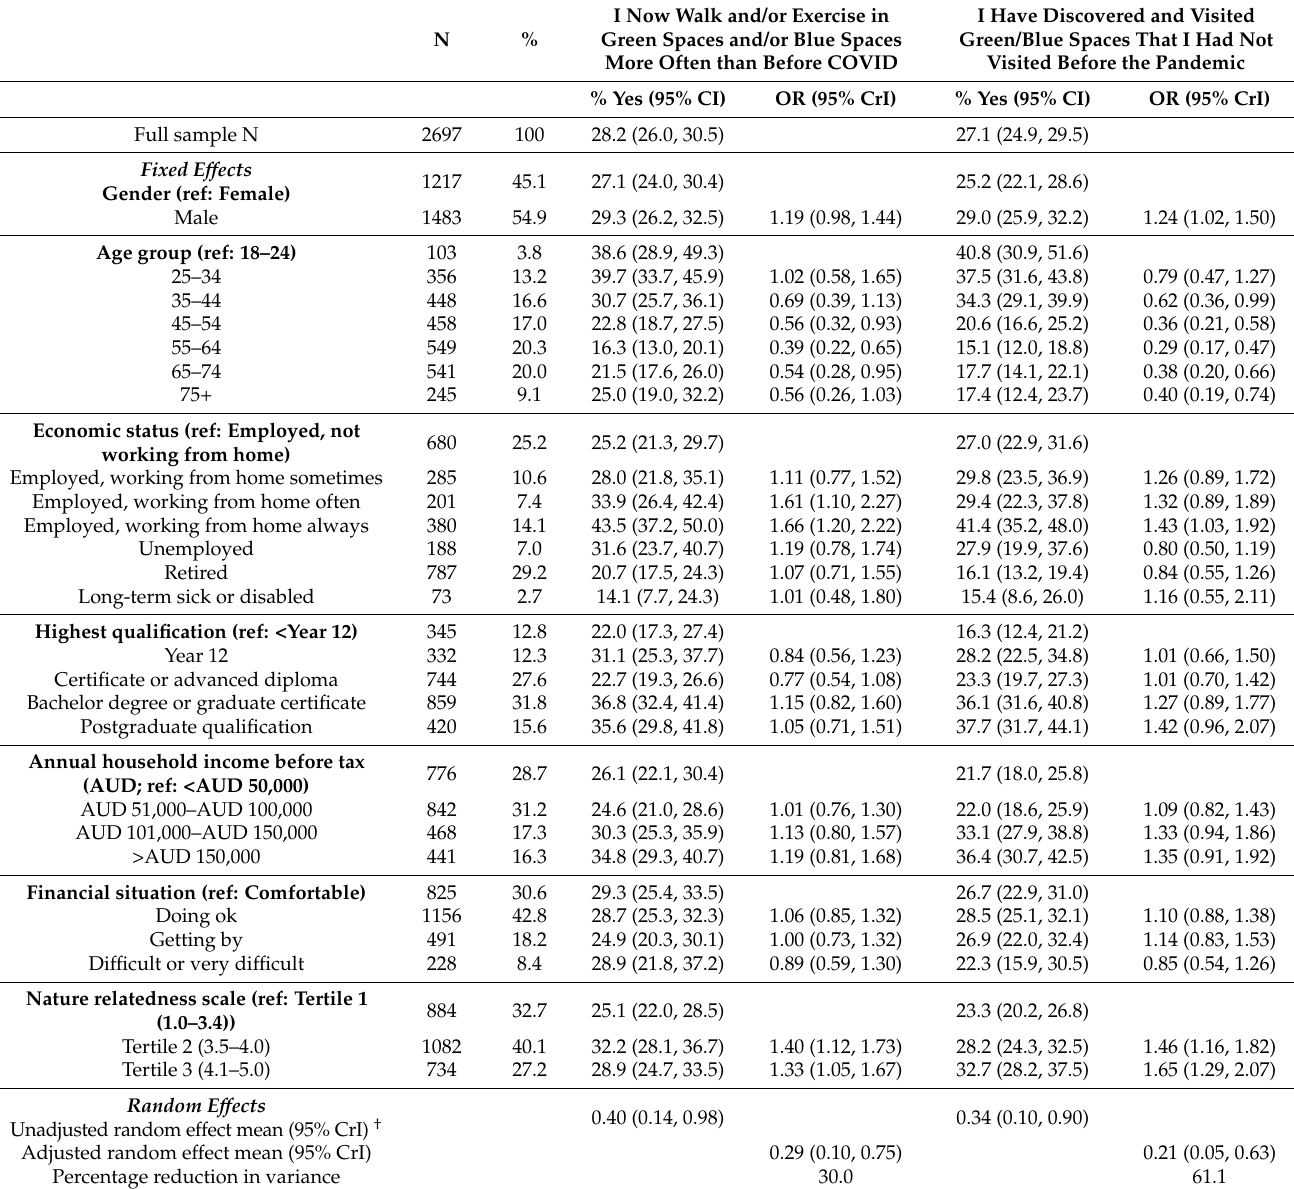
Table 6. Associations with exercise in and discovery of new green/blue spaces during the COVID-19 pandemic. I Now Walk and/or Exercise in I Have Discovered and Visited N % Green Spaces and/or Blue Spaces Green/Blue Spaces That I Had Not More Often than Before COVID Visited Before the Pandemic % Yes (95% CI) OR (95% CrI) % Yes (95% CI) OR (95%